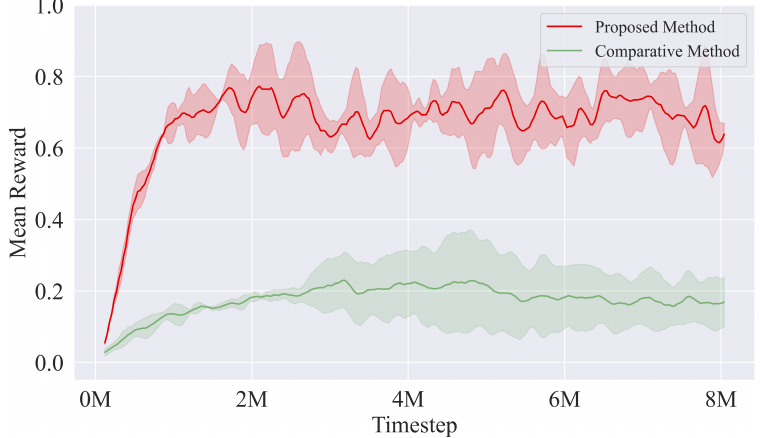
Figure 2. Mean reward of an episode for the proposed hierarchical method and the end-to-end comparative method.